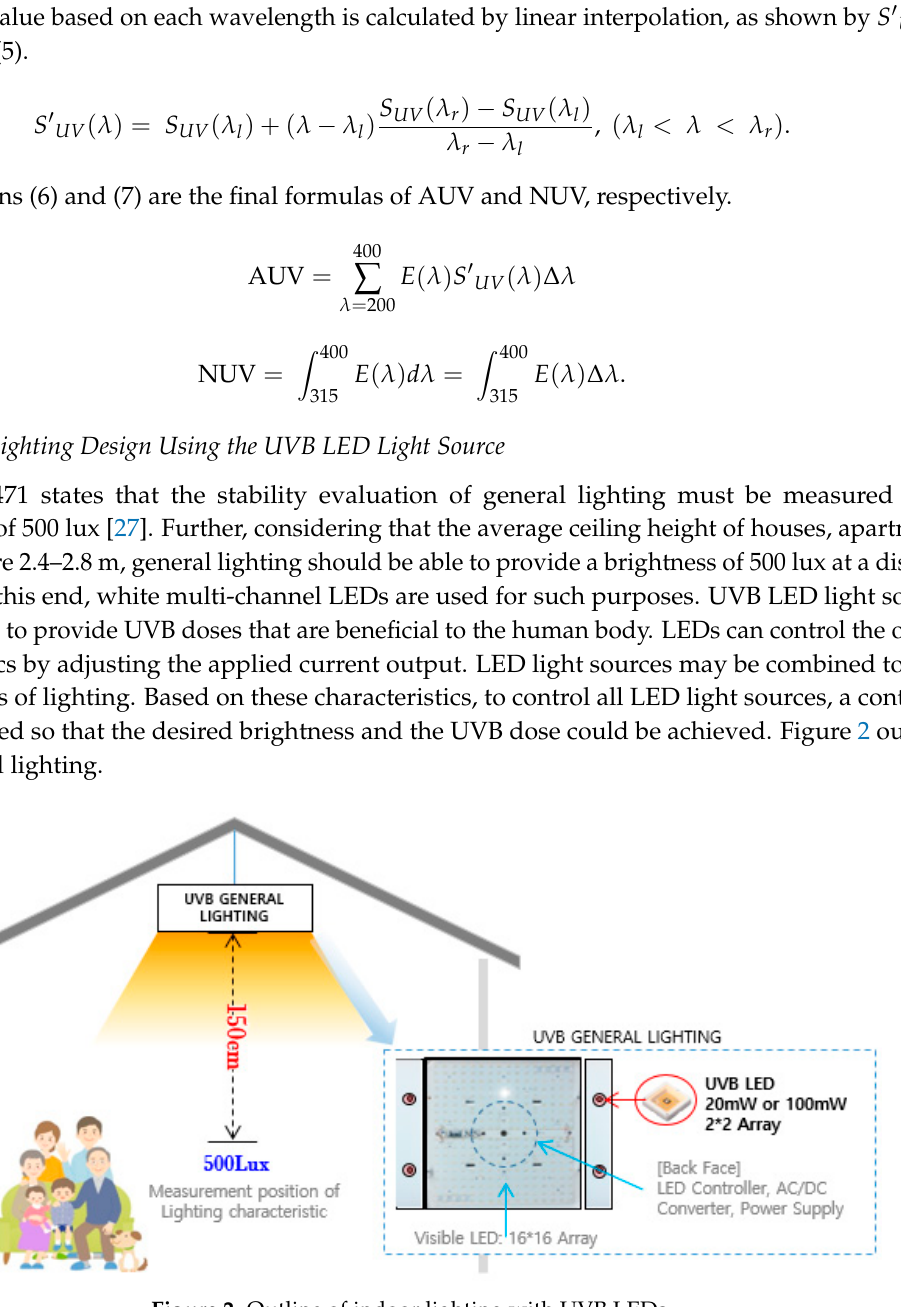
Figure 2. Outline of indoor lighting with UVB LEDs.